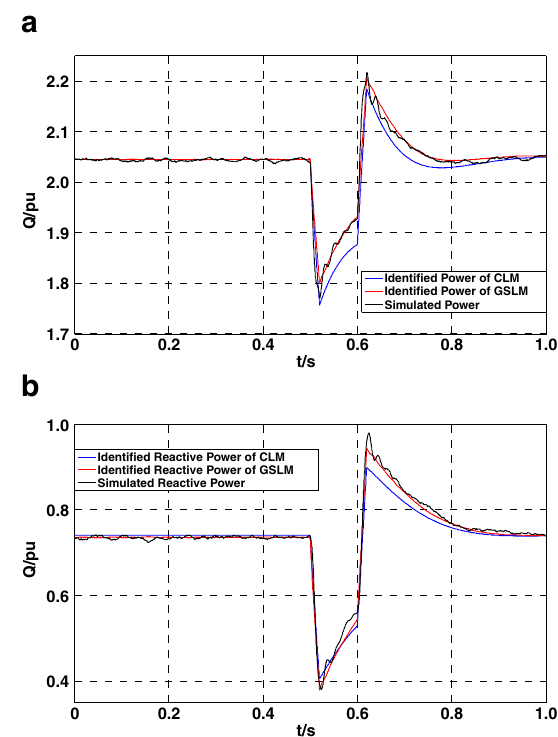
Fig. 11 Fitting curves of the third load level under discharging